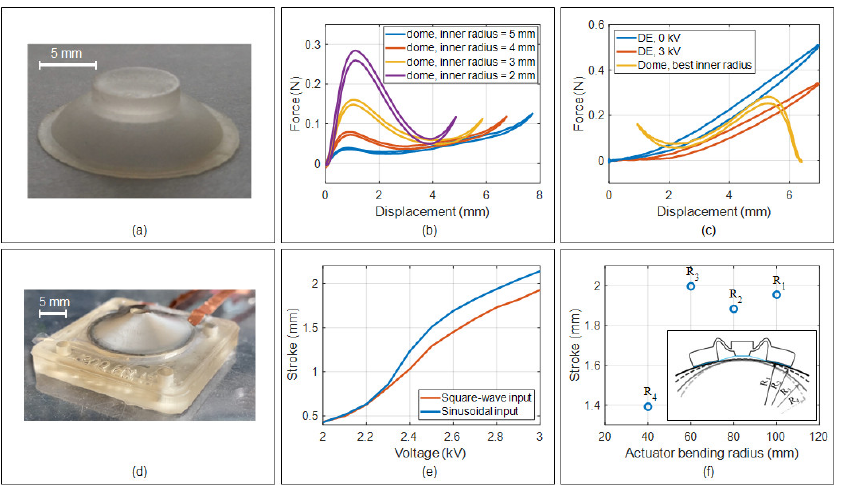
Figure 1. Silicone-based dome as negative-rate bias spring ( a ), load-deformation behavior ( b , c ), DE actuator ( d ), DEA stroke ( e ), stroke for different bending radii ( f ).